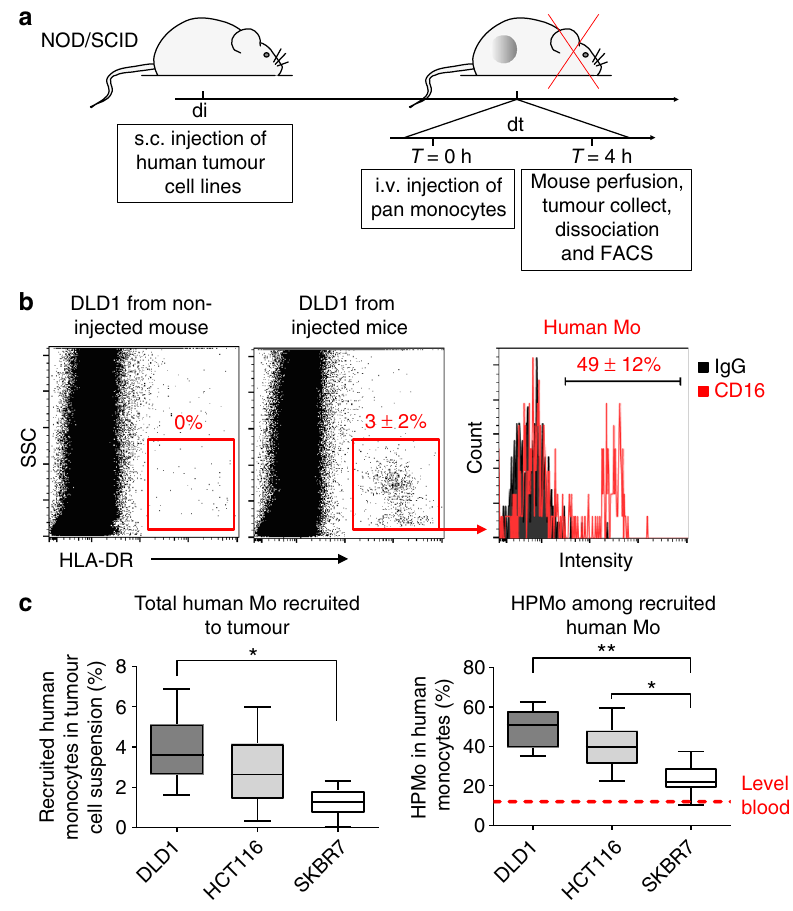
Fig. 1 Human tumour xenografts recruit human proangiogenic monocytes. a Time course protocol of the assay of human monocyte recruitment to human tumour xenograft (colorectal adenocarcinoma DLD1, colorectal carcinoma HCT116 and breast carcinoma SKBR7) in vivo. Human tumour xenografts were injected subcutaneously at day di and let grow to reach 0.5 cm 3 of tumour volume. The mice were then i.v. injected at day dt with freshly isolated human monocytes. After 4 h mice were perfused with PBS-EDTA and killed to collect tumours that were then dissociated for FACS analysis of recruited human monocytes. b FACS analysis of recruited human proangiogenic monocytes (HLA-DR+CD16+). Human HLA-DR staining identi fi ed human monocytes recruited to DLD1 xenograft. Gating on HLA-DR+ cells allowed quanti fi cation of human proangiogenic monocytes (CD16+). c Quanti fi cation of the percentage of total human monocytes within tumour cell suspension (left) and percentage of HPMo within recruited human monocytes ( n = 12 tumours from six mice per group injected with monocytes from the same donor in each experiment, the data were combined from two independent experiments). About 20 – 60% of recruited human monocytes were from proangiogenic subset with the highest proportion for xenografts of colorectal adenocarcinoma cells DLD1 and the lowest for xenografts of breast carcinoma SKBR7. The data are presented as boxplot with median (horizontal line in boxes), 25 – 75th percentiles (box limits) and Min – Max indicated by whiskers. * p < 0.05, ** p < 0.001 in